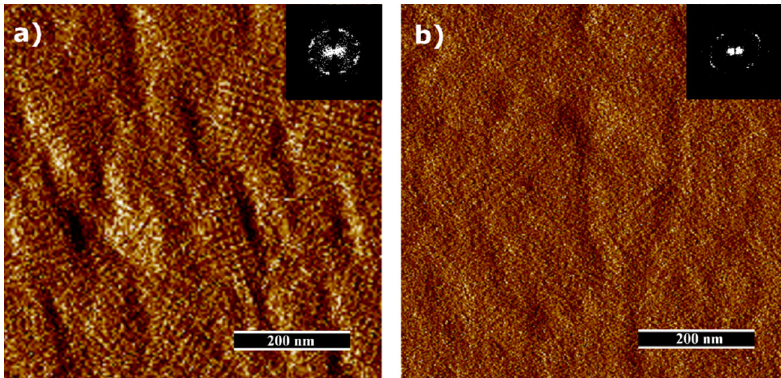
Figure 3 . AFM micrograph of crystalline SbpA films onto silicon wafers under electrochemical control of the bulk potential (–1 V). The recrystallization buffer contained either FeSO 4 ( a ) or FeCl 2 ( b ). Recrystallization was checked after 210 min at RT. Insets show the resulting Fourier spectra from the respective images. Scale bars = 200 nm.